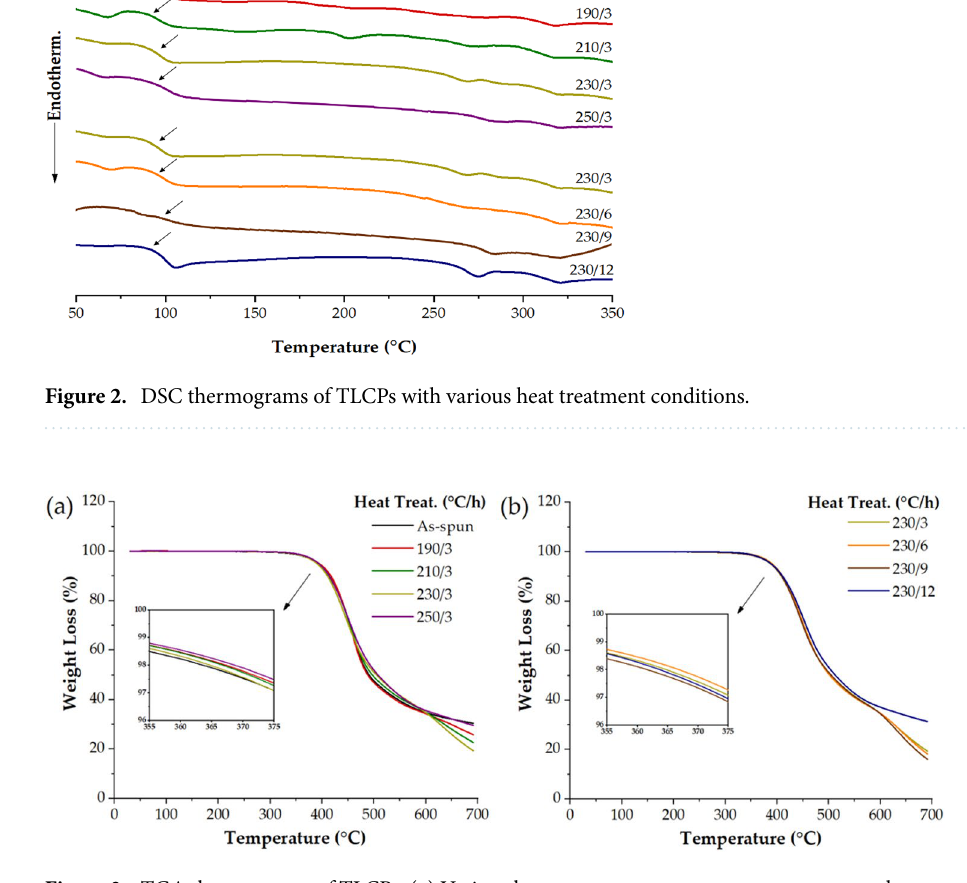
Figure 3. TGA thermograms of TLCPs. ( a ) Various heat treatment temperatures at a constant heat treatment time, ( b ) various heat treatment times at a constant heat treatment